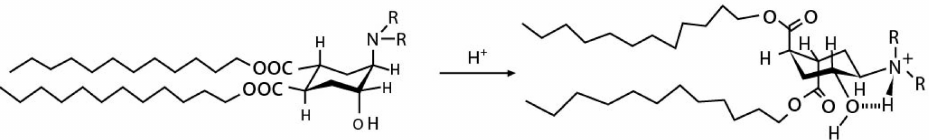
Figure 6. Conformational switch of trans-2-aminohexanol